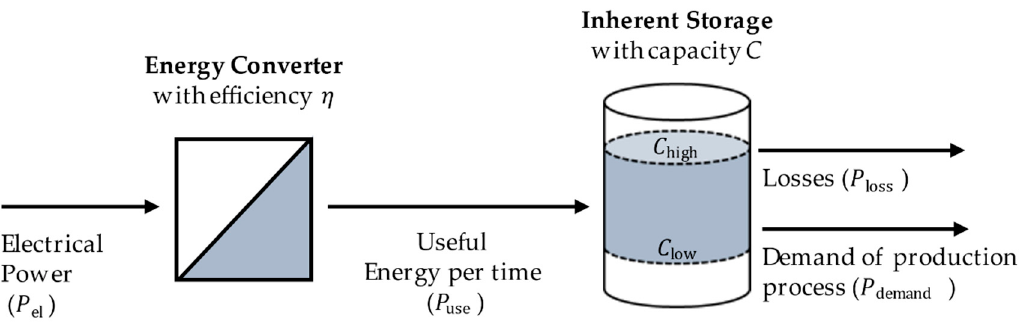
Figure 1. Simplified substitute model of an inherent energy storage consisting of the energy converter, which converts electricity into the energy form required by the production process and the inherent storage capacity.